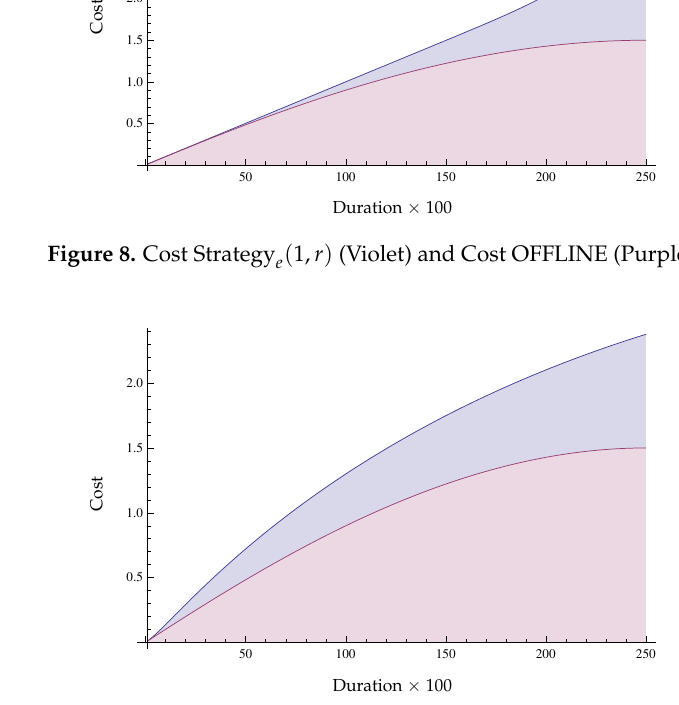
Figure 9. Cost Strategy